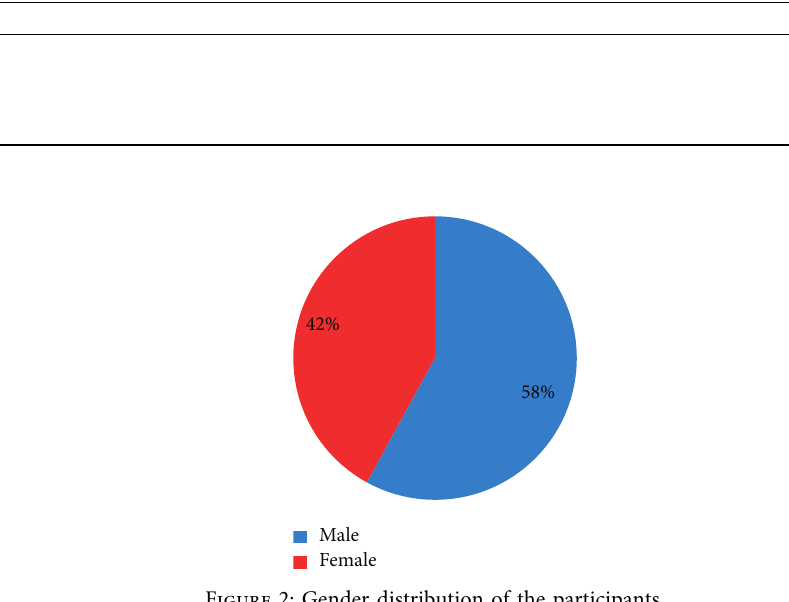
Table 4: Indices used for evaluation of postoperative pain.